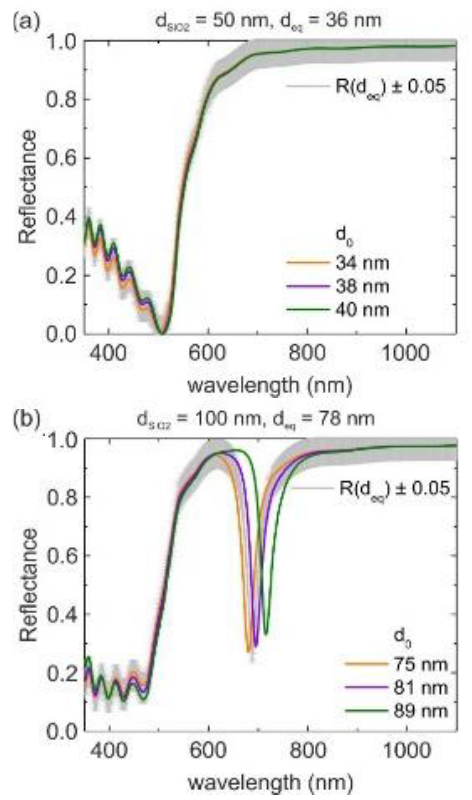
Fig. 3. (a) Reflectance of a system displaying levitation with = 1500 nm, (cid:6) = 30 nm, (cid:6) = (cid:6) = 36 nm, and (cid:6) (cid:17)(cid:13) (cid:11)(cid:12) (cid:18)(cid:19)(cid:20)(cid:21)(cid:7)(cid:22)(cid:23)(cid:19) (cid:7)(cid:8) (cid:6) = 50 nm, and an assumed error in the reflectance of ± 0.05 (cid:13)(cid:14)(cid:15) (cid:16) (in grey). For the same set of parameters, but separation distances (cid:6) (cid:18)(cid:19)(cid:20)(cid:21)(cid:7)(cid:22)(cid:23)(cid:19) = (cid:6) (cid:24) of 34, 38 and 40 nm, results are shown in orange, purple and green colors. These last systems do not yield levitation. (b) Results for the same set of parameters as in = 100 nm, thus, (cid:6) = panel (a), but considering (cid:6) (cid:13)(cid:14)(cid:15) (cid:18)(cid:19)(cid:20)(cid:21)(cid:7)(cid:22)(cid:23)(cid:19) (cid:16) = 78 nm, and assuming an error of ± 0.05 (in grey). Also, (cid:6) (cid:7)(cid:8) for separation distances of (cid:6) (cid:18)(cid:19)(cid:20)(cid:21)(cid:7)(cid:22)(cid:23)(cid:19) = (cid:6) (cid:24) of 75, 81 and 89 nm, results are shown in orange, purple and green colors. These last systems do not display